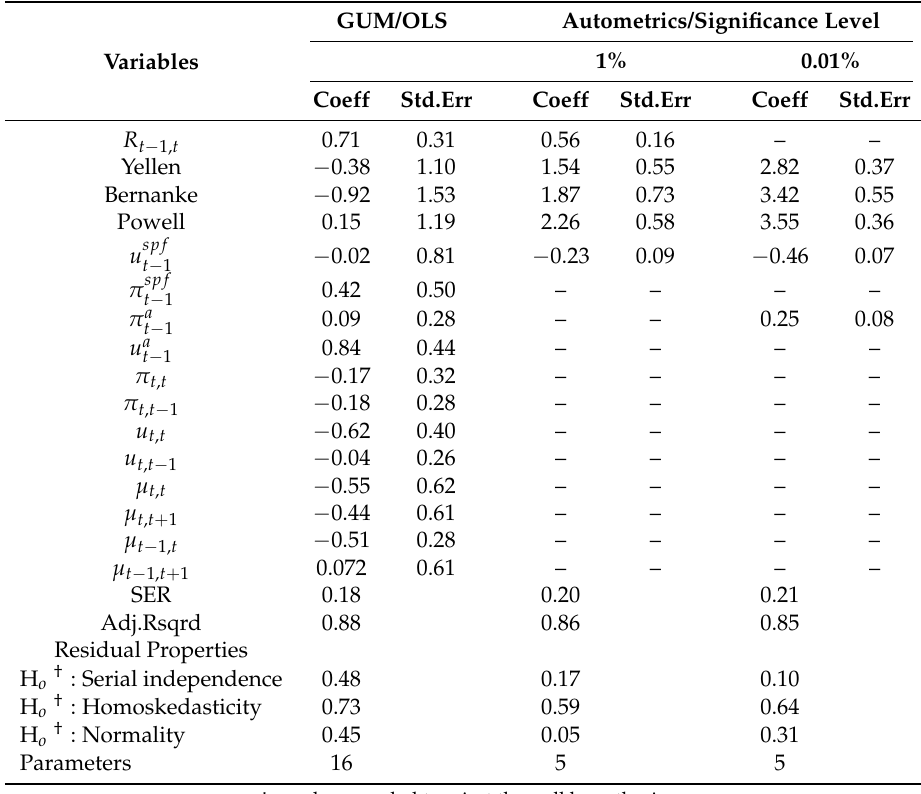
Table 1. Estimation Results for Single Equation for the Federal Funds Rate—Sensitivity to Target